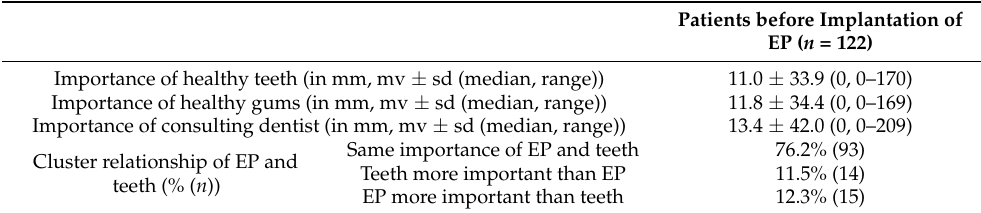
Table 2. Findings of the PRISM task across participants.